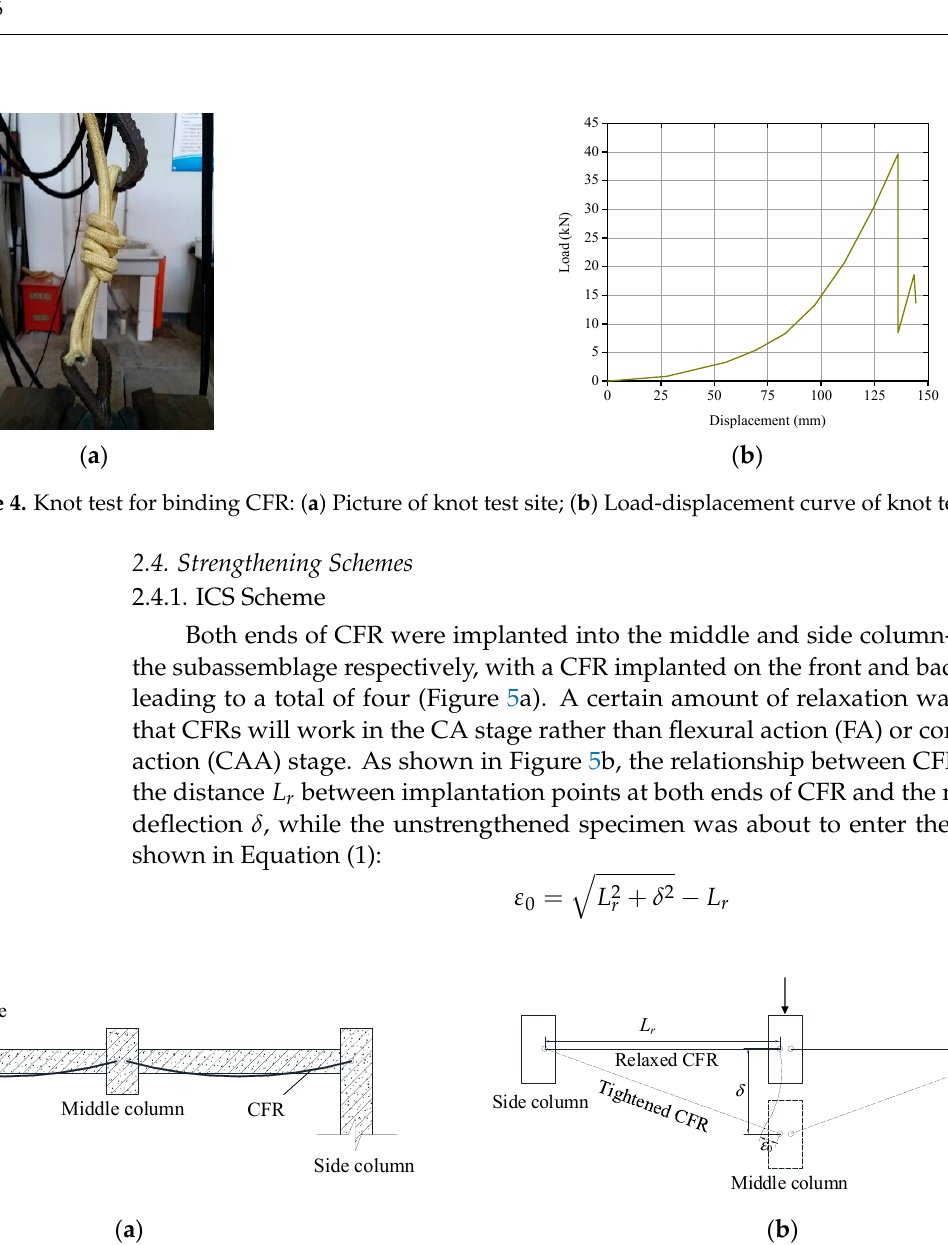
Figure 5. Schematic diagram of implanting CFR and CFR relaxation design: ( a ) Schematic diagram of implanting CFR; ( b ) CFR relaxation design.